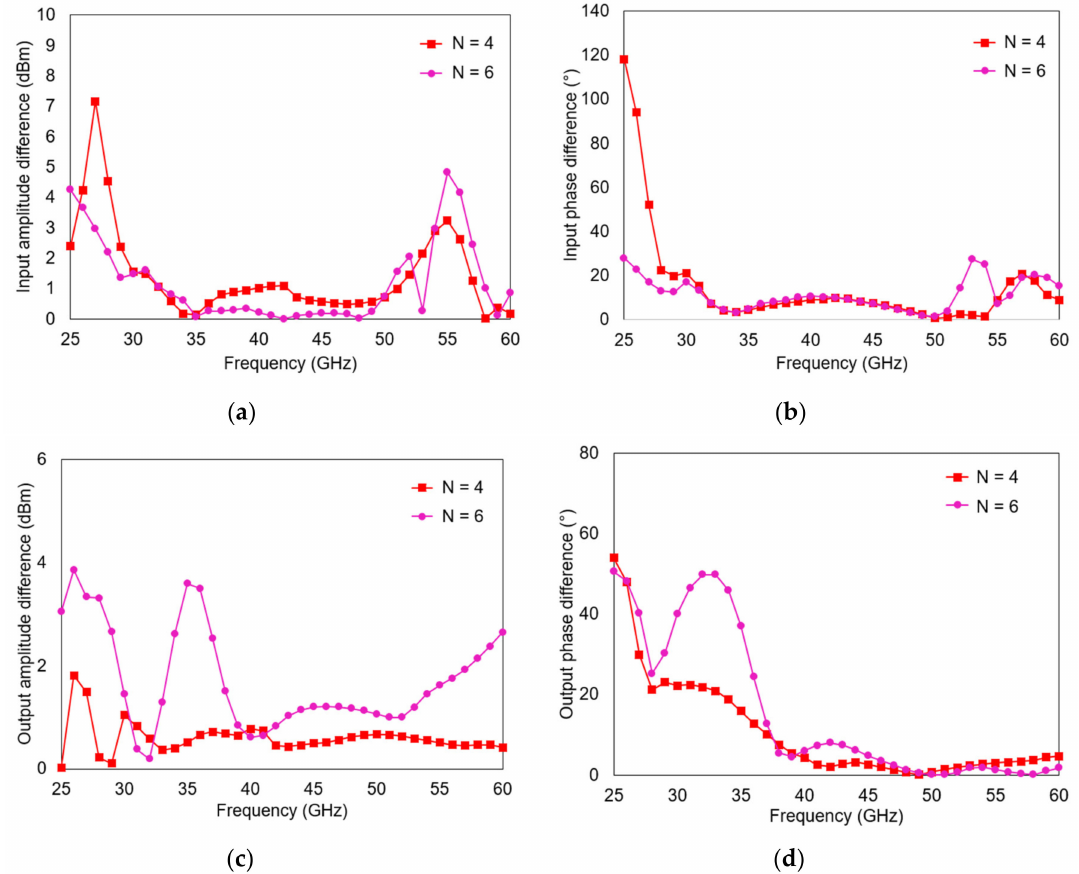
Figure 4. Simulated amplitude and phase di ff erences of the inputs and outputs between the first ZPS power cell and the last, according to the number of cells ( N ) when N / 2-way power dividers / combiners were inserted in the combining structure: ( a ) input amplitude di ff erence ( b ) input phase di ff erence ( c ) output amplitude di ff erence ( d ) output phase di ff erence.